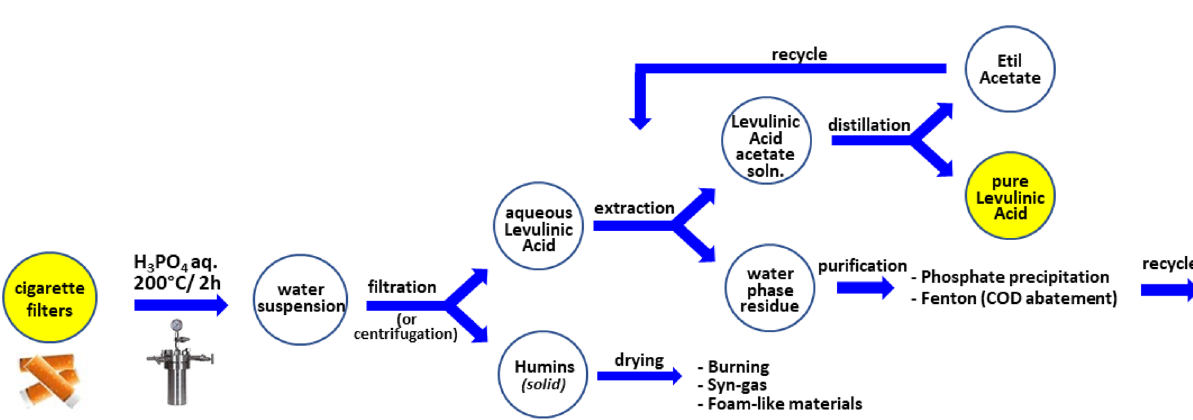
Figure 5. Process diagram of proposed